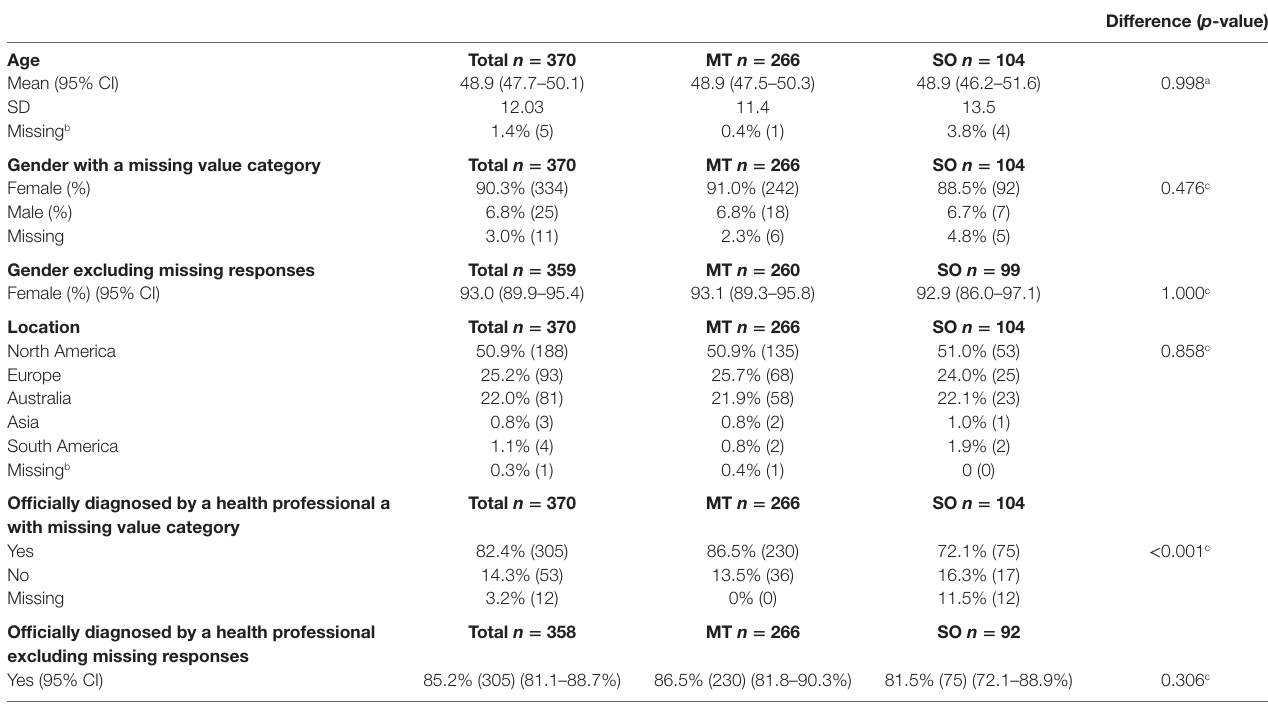
Table 2 | Demographics and diagnostic confirmation of all respondents, and within the Motion-Triggered (MT) and Spontaneous/Other (SO) onset groups, presented as a percentage of the group and raw